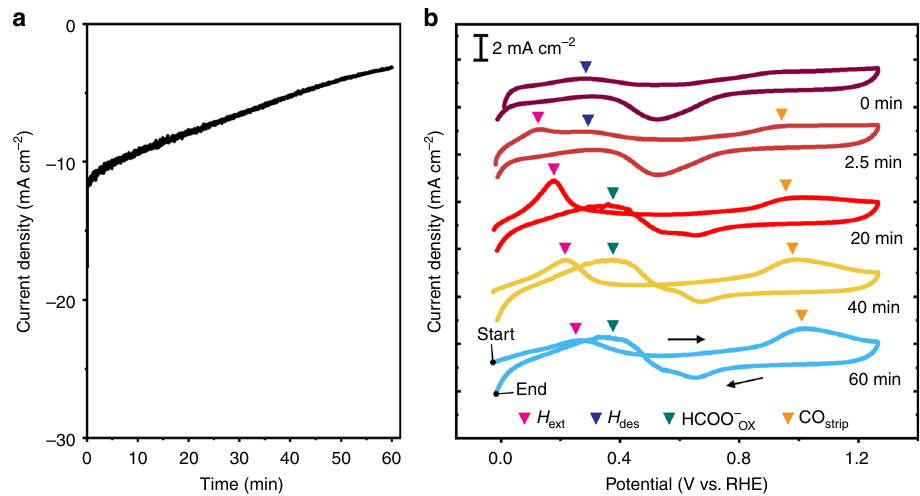
Fig. 2 Electrochemical oxidation behavior of HCOO − and CO products. a Current density vs. time curve of Pd 80 Ag 20 /C catalysts recorded during 1 h electrolysis. Chronoamperometry was conducted at − 0.18 V vs. RHE in a CO 2 -saturated electrolyte. The current density gradually decreases with time. b Cyclic voltammetry curves measured after electrolysis for different durations at − 0.18 V vs. RHE. The anodic peaks associated with H extraction (H ext ), H desorption (H des ), HCOO − oxidation (HCOO − ox ), and CO stripping (CO strip ) are indicated by pink, blue, green, and orange triangles,